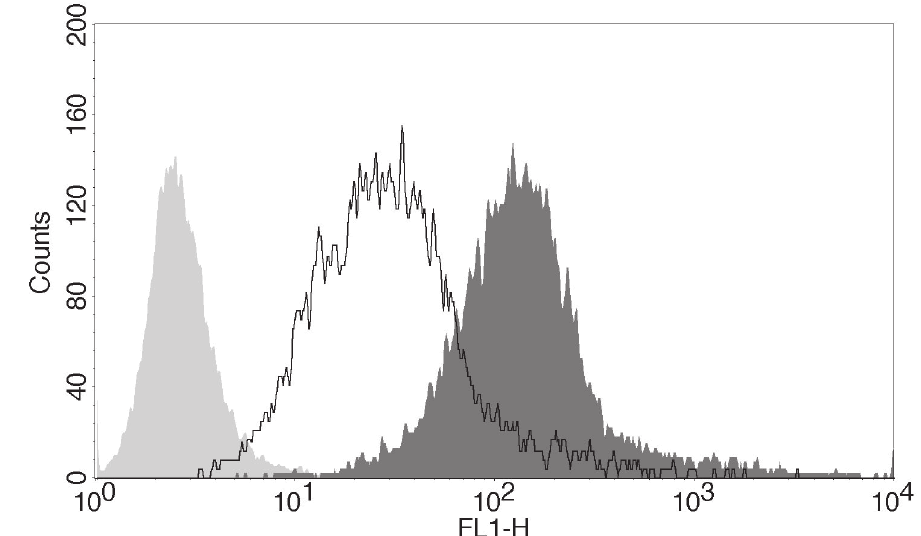
Figure 3. Flow cytometry analysis of the expression of co-stimulatory and antigen-presenting molecules in THP-1 cells stimulated with E. coli LPS, NTHi LOS or killed NTHi. THP-1 cells were stimulated with 1.0 µ g/ml of LPS, or LOS at concentrations of 1, 5, 10, and 15 µ g/ml, or corresponding amounts of killed NTHi: 4.762 × 10 7 , 2.381 × 10 8 , 4.762 × 10 8 , 7.143 × 10 8 CFU per 0.5 × 10 6 THP-1 cells for 24 hours. Un- stimulated THP-1 cells (0.5 × 10 6 ) in complete culture medium served as a negative control. Cell surface expression of CD54 (A), CD86 (B), CD40 (C), CD58 (D) HLA-ABC (E), and HLA-DR (F) was measured and data expressed as the mean fluorescence intensity (MFI) with the standard error of the mean (SEM) (n = 3). *, P < 0.05 compared to the unstimulated control; +, P < 0.05 between LOS and killed NTHi; • , P < 0.05 between LPS and LOS. (G): Original histograms of 1 representative experiment showing HLA-DR expression in THP-1 cells stimulated with 10 µ g/ml of NTHi LOS (dark grey), or with the corresponding amounts of killed NTHi (open histogram); light grey: unstimulated cells stained with the isotype control